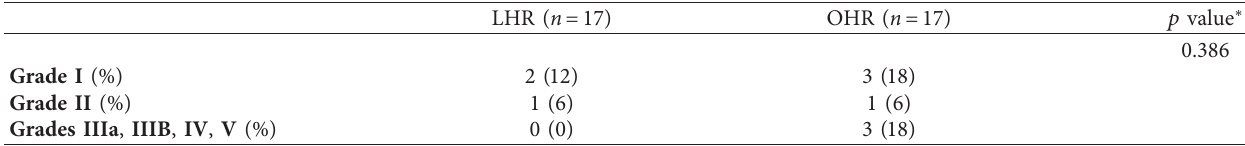
Table 3: Postoperative complications according to the Clavien–Dindo